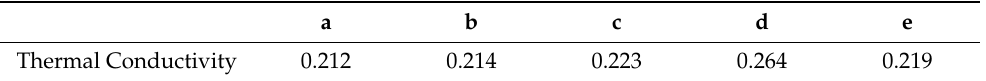
Table 4. Calculations of the thermal conductivity of different models at 300 K (W · (m · K) − 1 ). a b c d e Thermal Conductivity